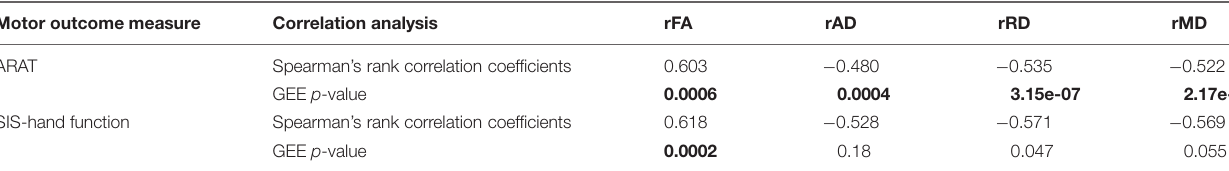
TABLE 3 | Correlation coefficients of DTI measures and motor